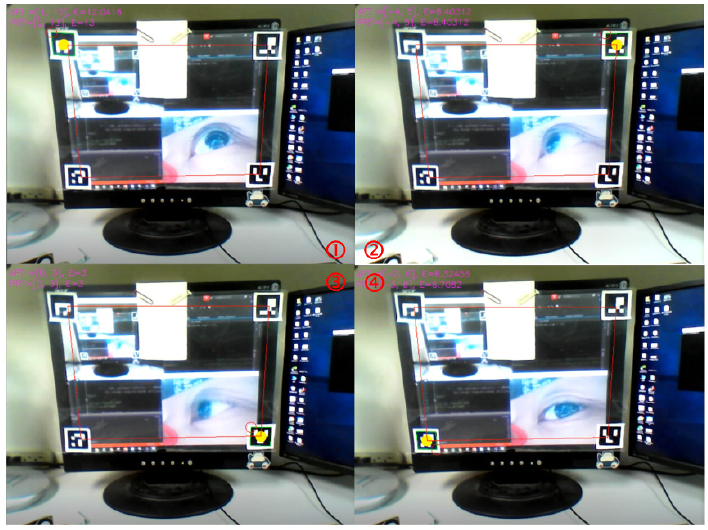
Figure 13. Diagram of tracking four markers’ center points with the outward camera for calibration ① When the user gazes at the marker ID1 for calibration. ② When the user gazes at the marker ID2 for calibration. ③ When the user gazes at the marker ID3 for calibration. ④ When the user gazes at the marker ID4 for calibration.